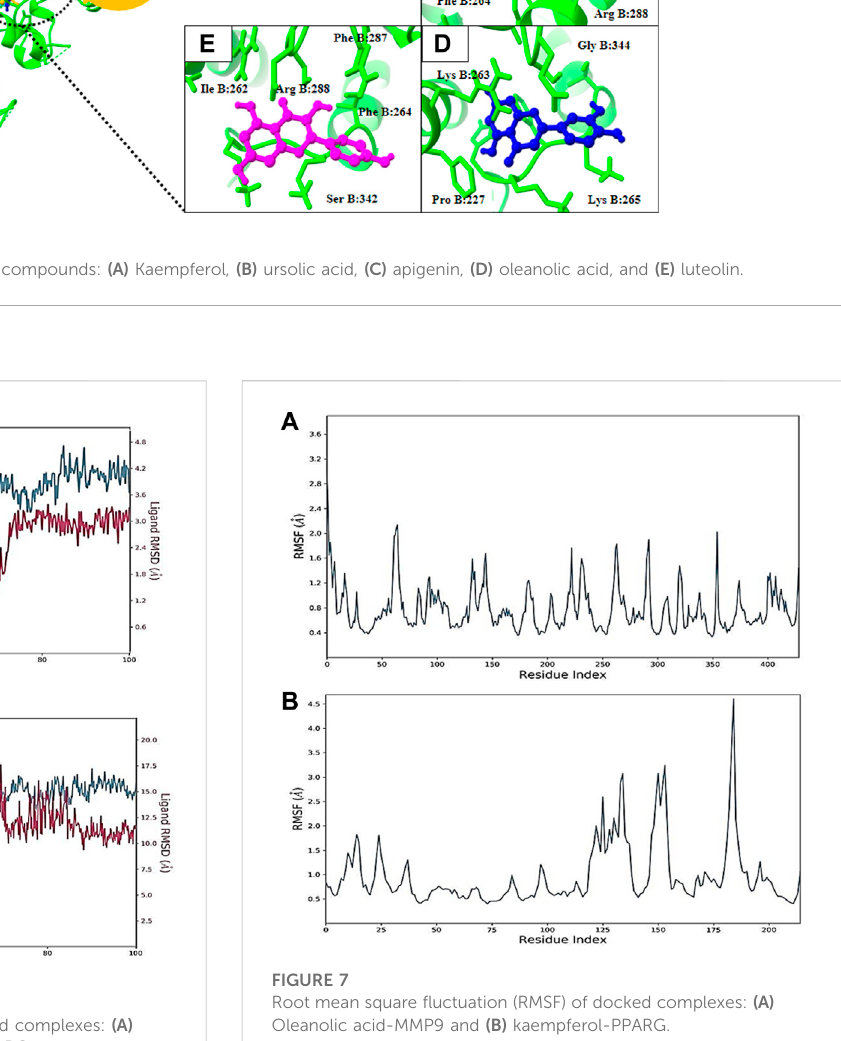
Figure 7. The docked complexes of oleanolic acid with MMP9 and PPARG with kaempferol showed RMSF values ranging from 0.4 ±